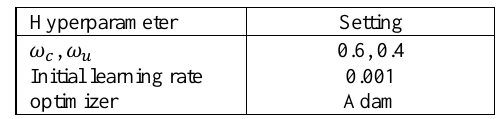
Table 2. Hyperparameter